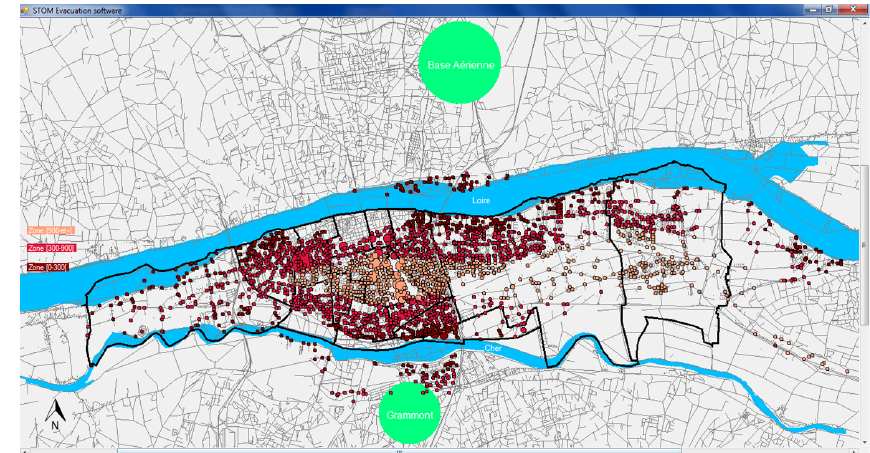
Figure 7. Division of each of the two zones (relative to the two rivers) into three subzones. Zone [0, 300] is the area that lies between 0 and 300m from the river.